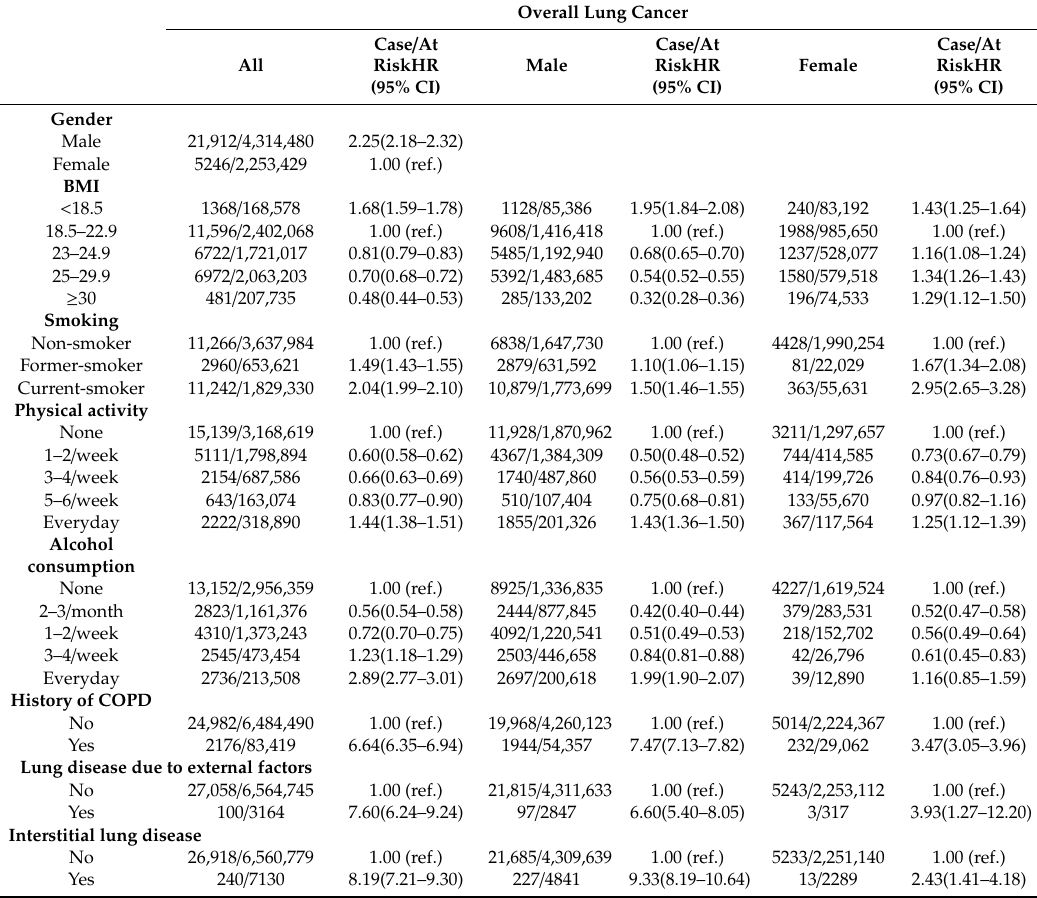
Table 4. Hazard ratios of total lung cancer incidence according to the general information of the study subjects.